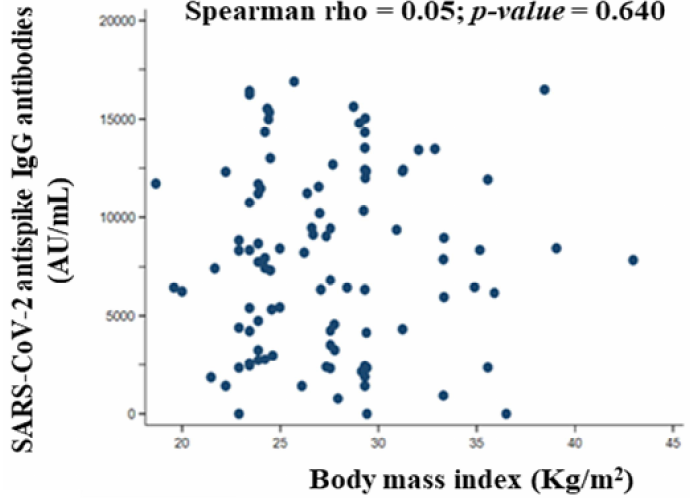
Figure 5. Correlation between total SARS-CoV-2 anti-spike IgG antibody titer (AU/mL) quantified 20 days after administration of the second dose of vaccine and body mass index of participants.